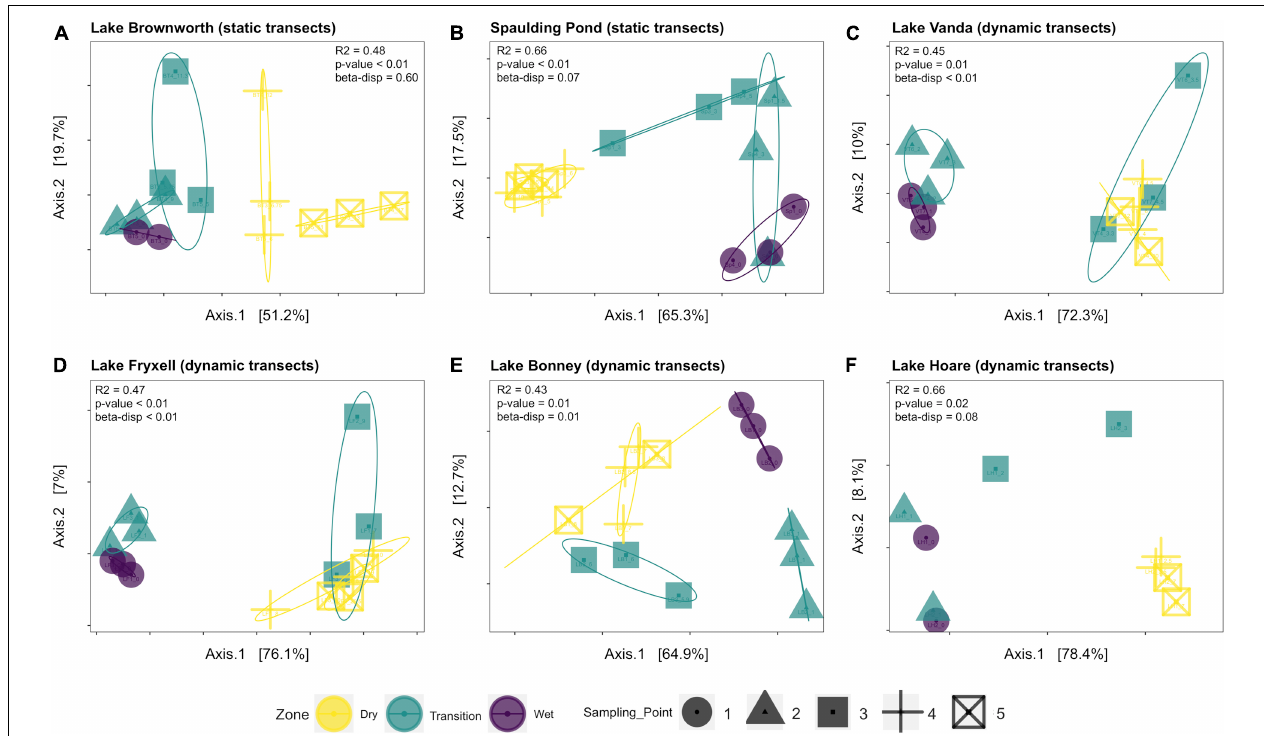
FIGURE 5 | Principal coordinate analysis (PCoA) of microbial community data based on a weighted UniFrac distance matrix for each lake along each transect: (A) Lake Borwnworth; (B) Spaulding Pond; (C) Lake Vanda; (D) Lake Fryxell; (E) Lake Bonney; (F) Lake Hoare. The significance between weighted UniFrac distance was calculated using PERMANOVA. The assumption for homogeneity of group dispersion was tested with betadisper function. Ellipses on the PCoA plot highlight the deviations from the mean for each clustered group of samples representative of different zones of the transects (95% confidence